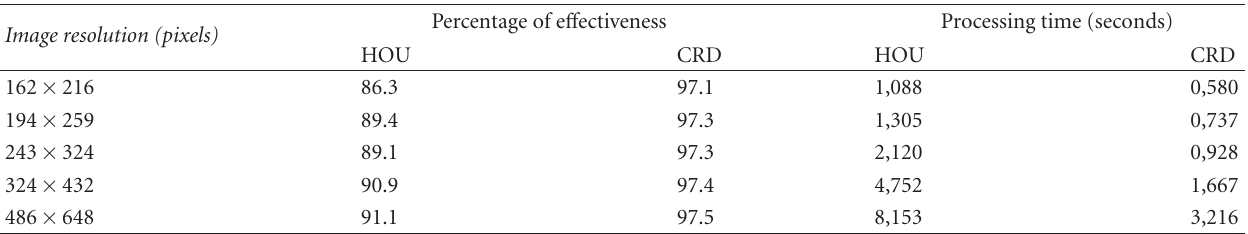
Table 2: Performances of HOU and CRD approaches measured in terms of percentage of e ff ectiveness and processing times. Image resolution (pixels)